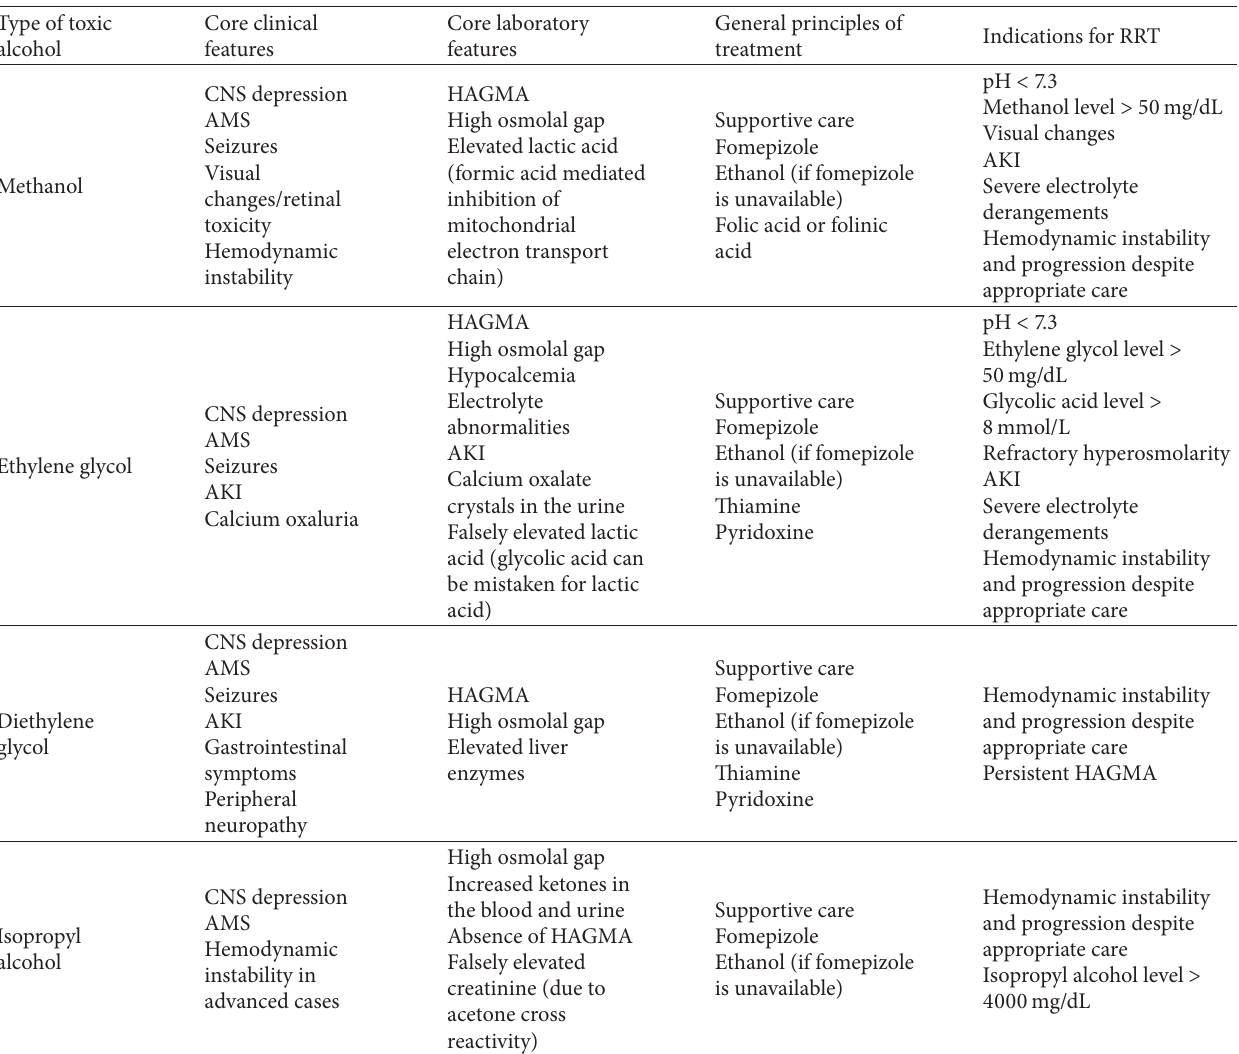
Table 2: The features of toxic alcohol